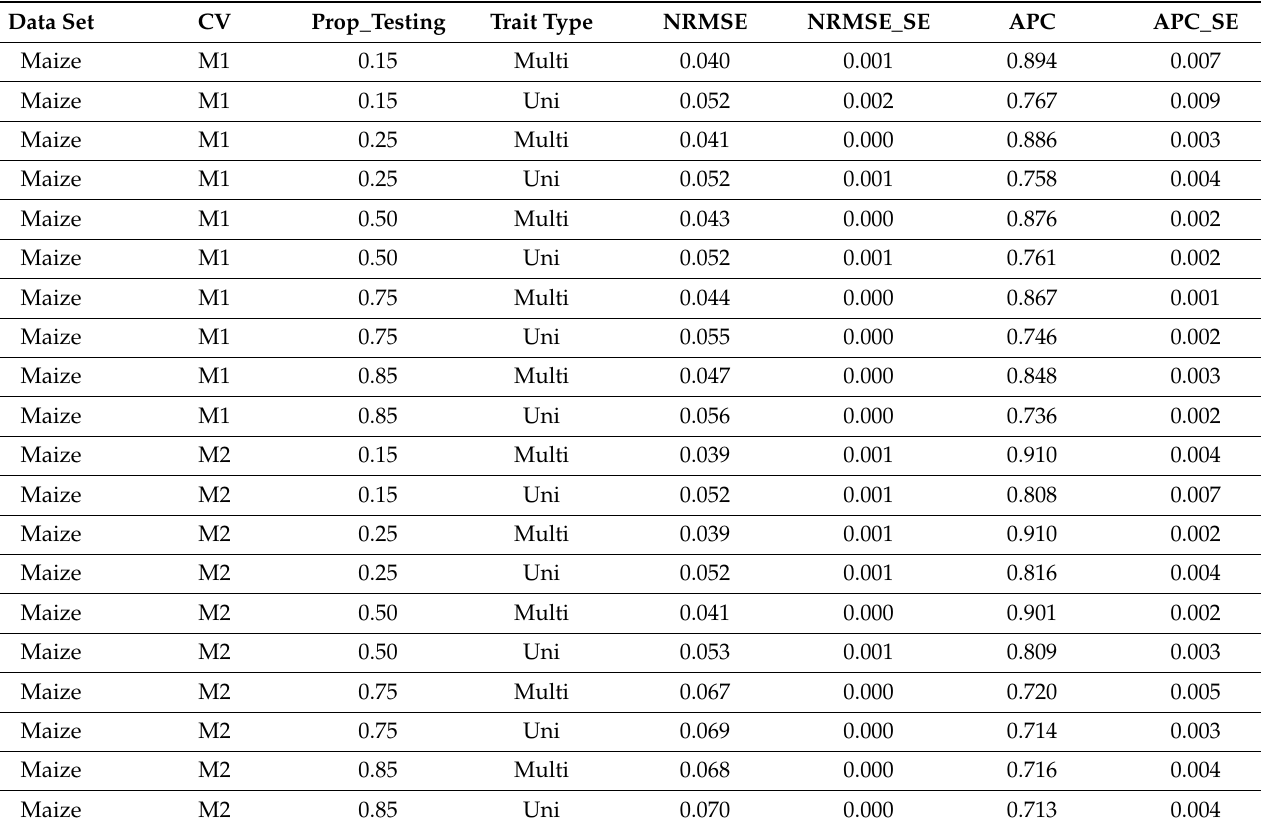
Table A1. Prediction performance for the complete maize data in terms of normalized root mean square error (NRMSE) and Average Pearson’s correlation (APC) of the four sparse testing methods (CV) under the following proportion of testing (Prop_testing): 15% (0.15), 25% (0.25), 50% (0.5), 75% (0.75) and 85% (0.85). NRMSE_SE denotes the standard error of NRMSE, and APC_SE denotes the standard error of